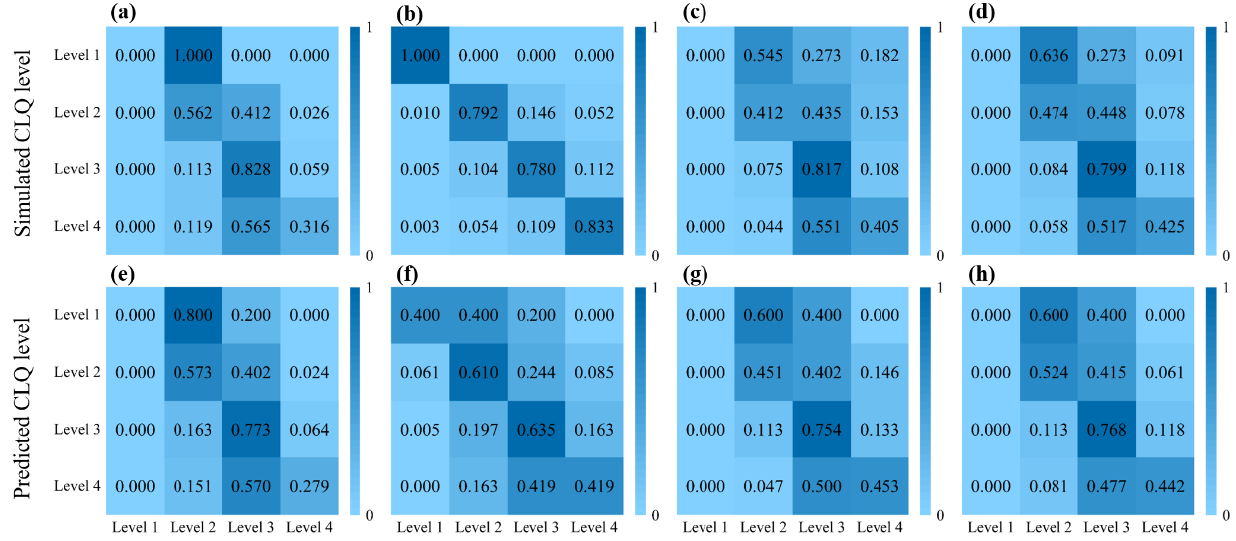
Figure 5. Results from four machine learning models showing the confusion matrix of the ( a ) BPNN training dataset, ( b ) RF training dataset, ( c ) DT training dataset, ( d ) SVM training dataset, ( e ) BPNN test dataset, ( f ) RF test dataset, ( g ) DT test dataset, and ( h ) SVM test dataset.